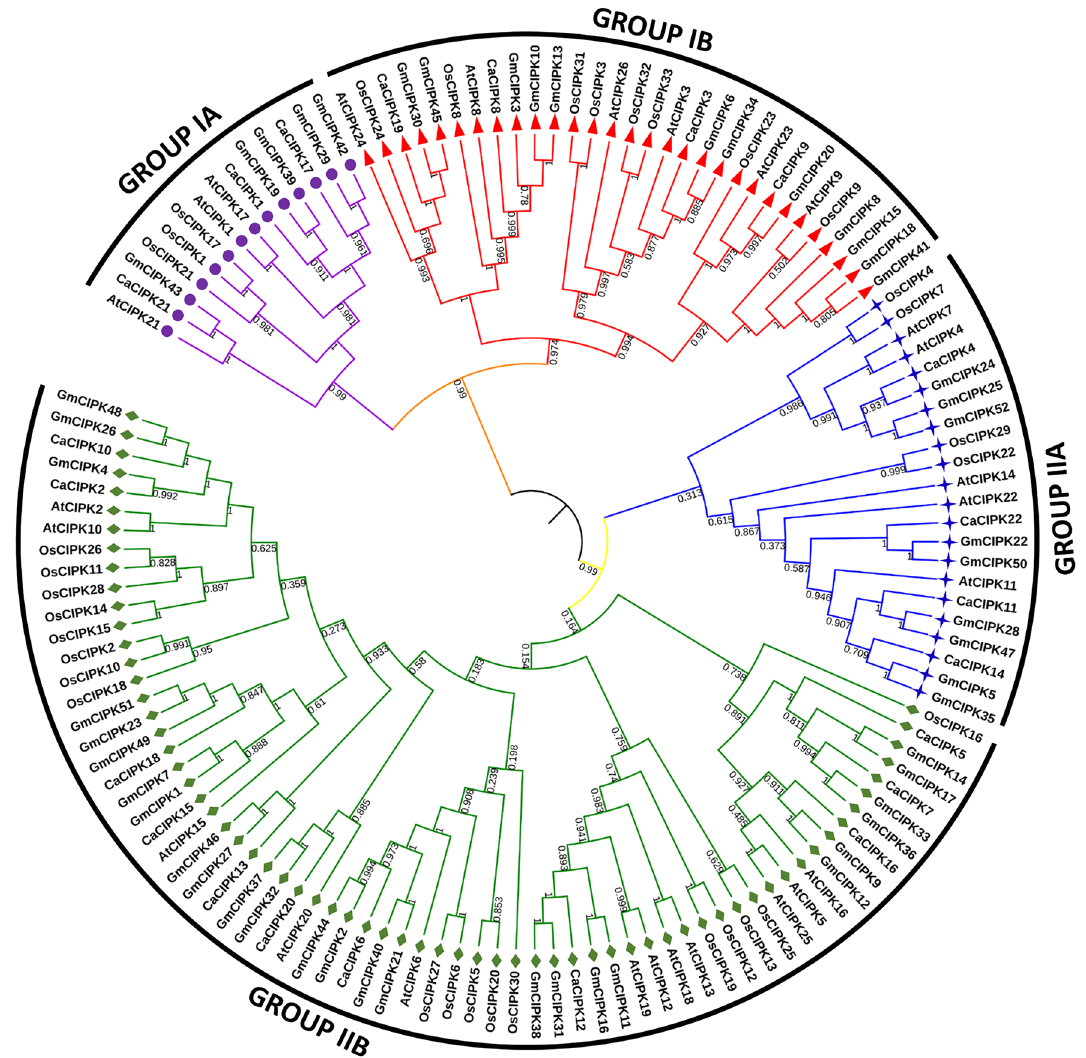
Figure 2. Phylogenetic relationship among CIPKs from different plants. Evolutionary relationship from Arabidopsis thaliana (At), Oryza sativa (Os), Glycine max (Gm) and Cicer arietinum (Ca) constructed using Neighbor-Joining method by using MEGA X software is shown via phylogenetic tree. Labels above the nodes represent bootstrap values calculated from 1000 replicates. The Groups IA, IB, IIA and IIB are indicated by violet, red, blue and green branch lines